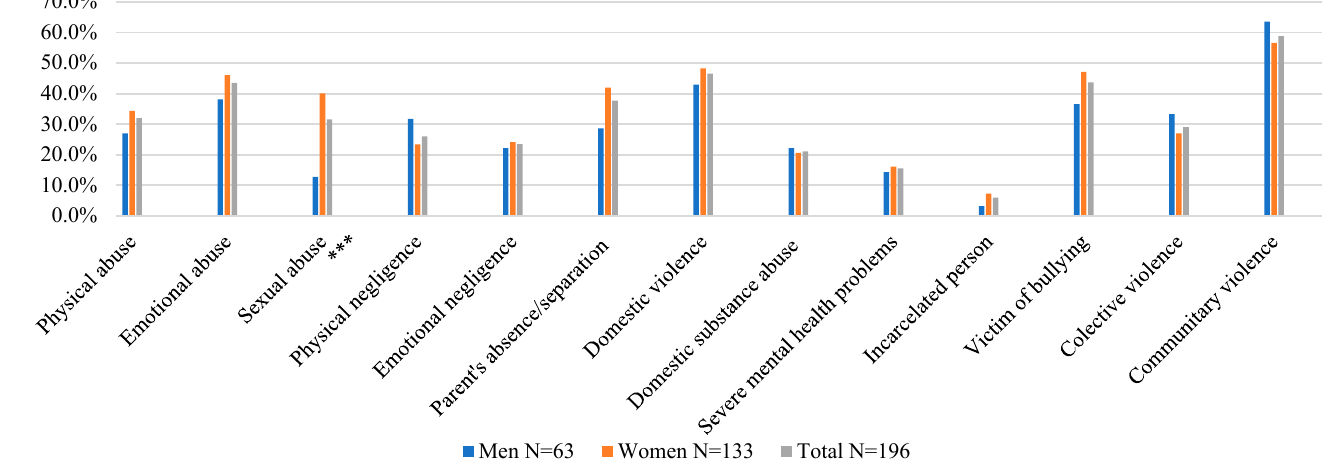
Figure 1. Adverse Childhood Experiences in Men and Women. p > 0.0001 ***.